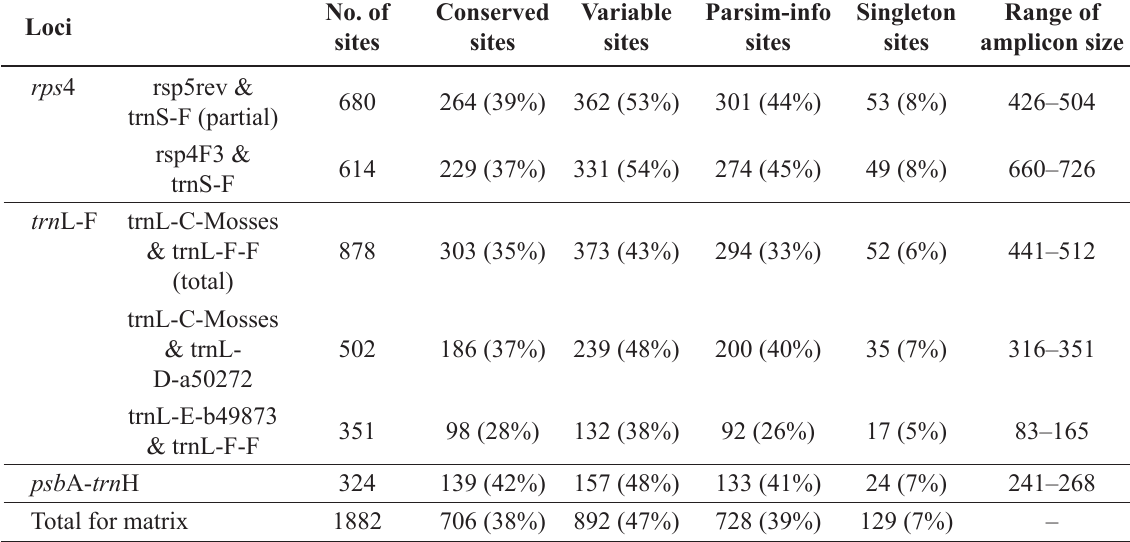
Table 3. Number of sequences obtained and number of informative sites for each marker. All the numbers refer to the aligned matrix, except “Range of amplicon size”, which refers to unaligned sequences. rps 4F3 refers to the part of rps 4 obtained with the newly designed primers. trn L-F information is detailed for the two internal portions often sequenced and concatenated for older samples. Percentage values are indicated in brackets next to absolute values for conserved, variable, parsim-info and singleton